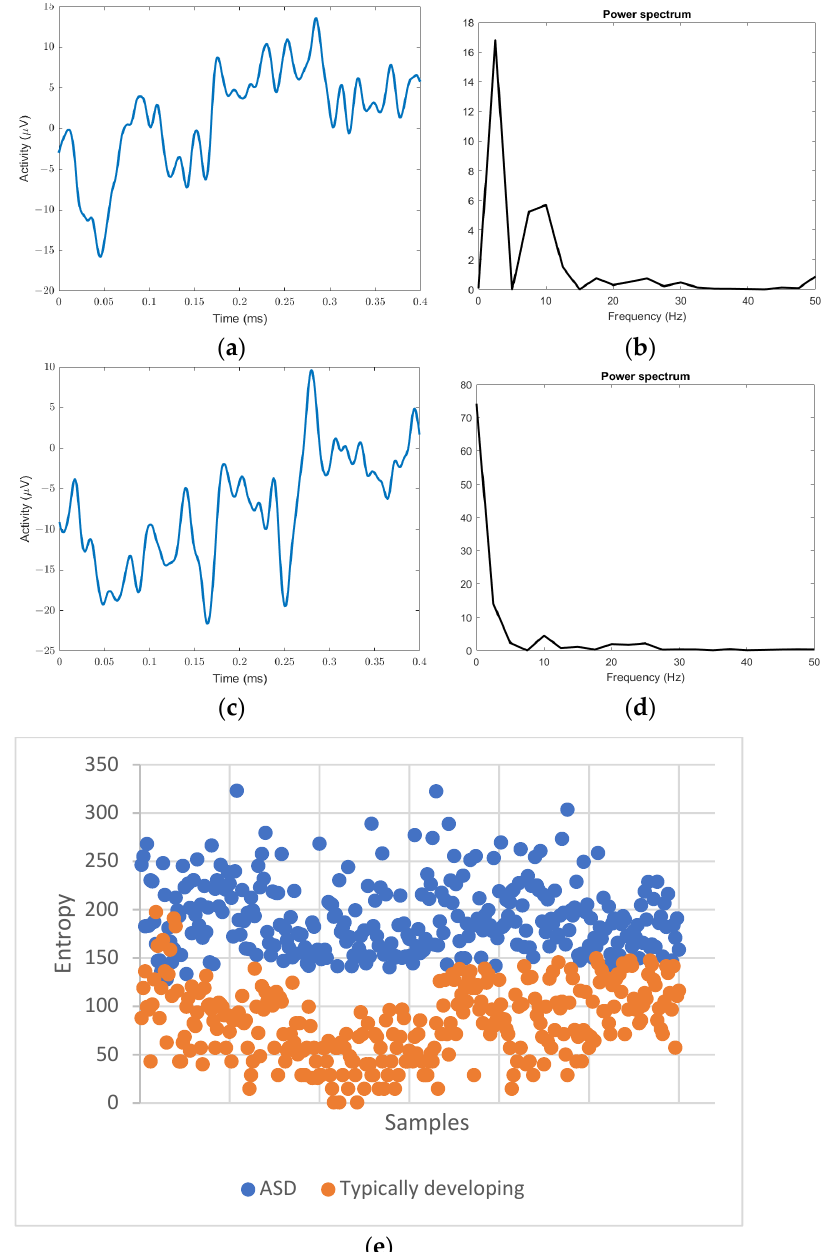
Figure 1. Sample EEG signals, their power spectrum, and the distribution of entropy dynamics between ASD and typically developing subjects. ( a ) ASD EEG sample, ( b ) power spectrum of ASD EEG sample, ( c ) typically developing EEG sample, ( d ) power spectrum of typically developing EEG sample, ( e ) distribution of entropy dynamics.